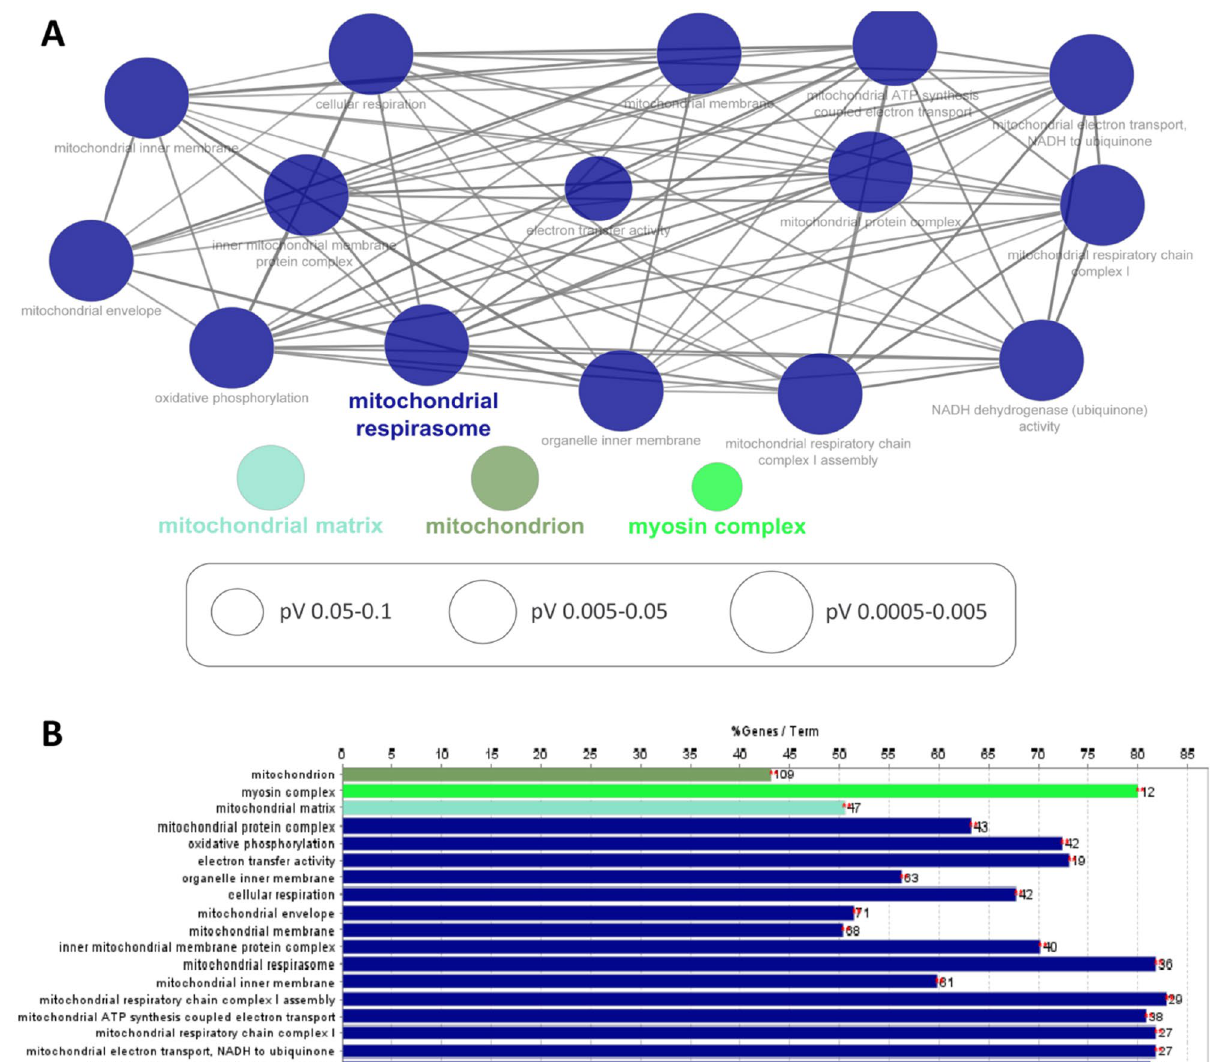
Figure 6. ITM2B interactome in the retina with the 360 proteins purified with the rabbit antibody (FC > 2 and p-value < 0.01). ( A ) GO-term network analysis. ( B ) Functional clusters and pathways identified with enriched proteins. %Genes/Term corresponds to the proportion of genes enriched in the functional clusters. Bars with the same color belong to the same functional